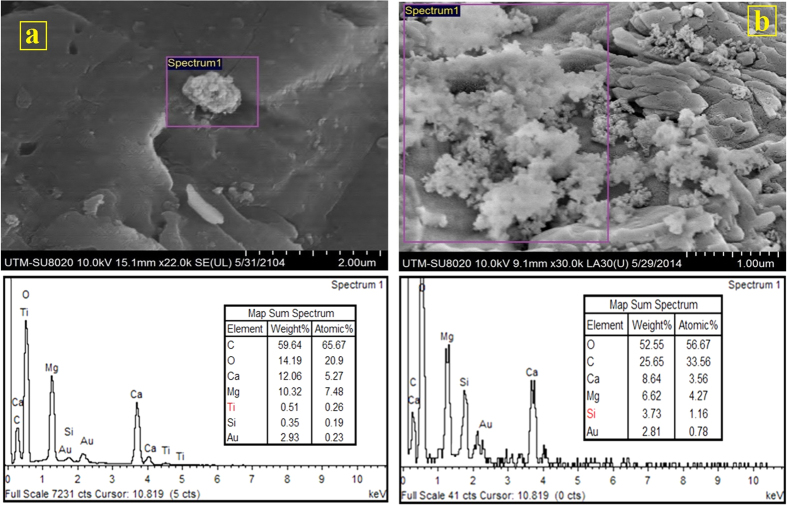
(a) FESEM-EDX analyses from dolomite grains after the transport experiments, (a) TiO2-NPs, (b) SiO2-NPs. (Right image was taken from a grain located in the top of column and left image was taken from a grain located in the entrance of column).